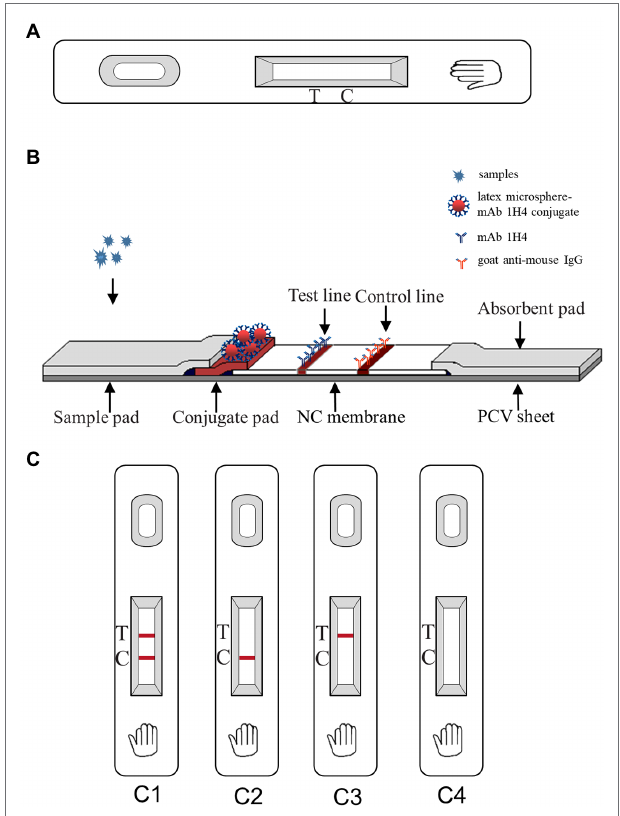
FIGURE 1 | Schematic diagram of the immunochromatographic strip (ICS) and interpretation of the results. (A) Outside view of the ICS; (B) Inside view of the ICS; (C) Interpretation of the ICS result. C1 indicates a positive result; C2 indicates a negative result; and C3 and C4 indicate an invalid